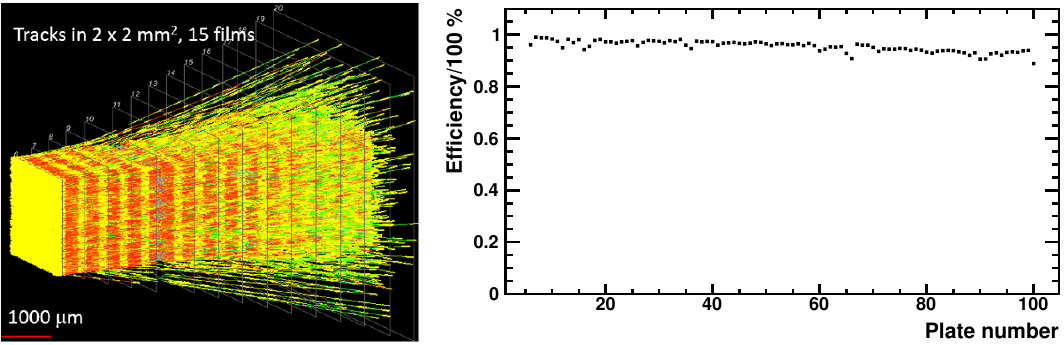
Figure 13 . Left: 3D display of reconstructed tracks. Right: (cid:12)lm-by-(cid:12)lm basetrack e(cid:14)ciency in one of the decay modules in 2016